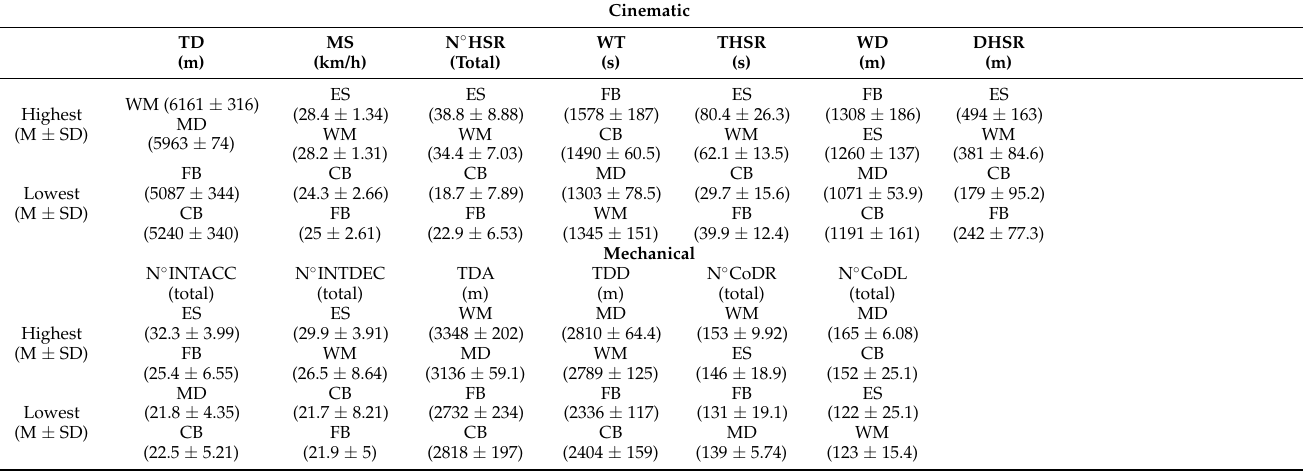
Table 5. Highest and lowest external load indicator differences among playing positions (central back, external striker, full back, midfielder, wide